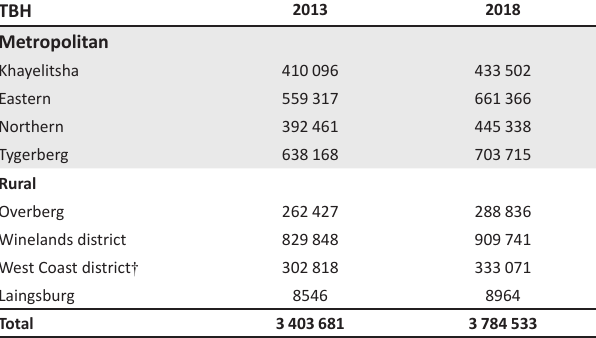
TABLE 1b: Western Cape province drainage populations 2013 and 2018